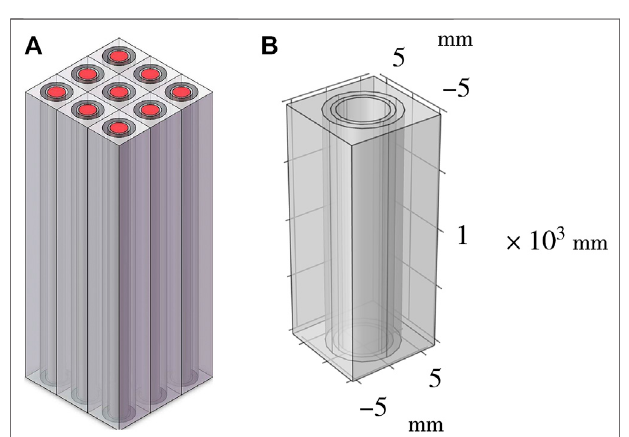
FIGURE 4 | Schematic diagram of (A) 3 × 3 channels model (B) single- channel model.